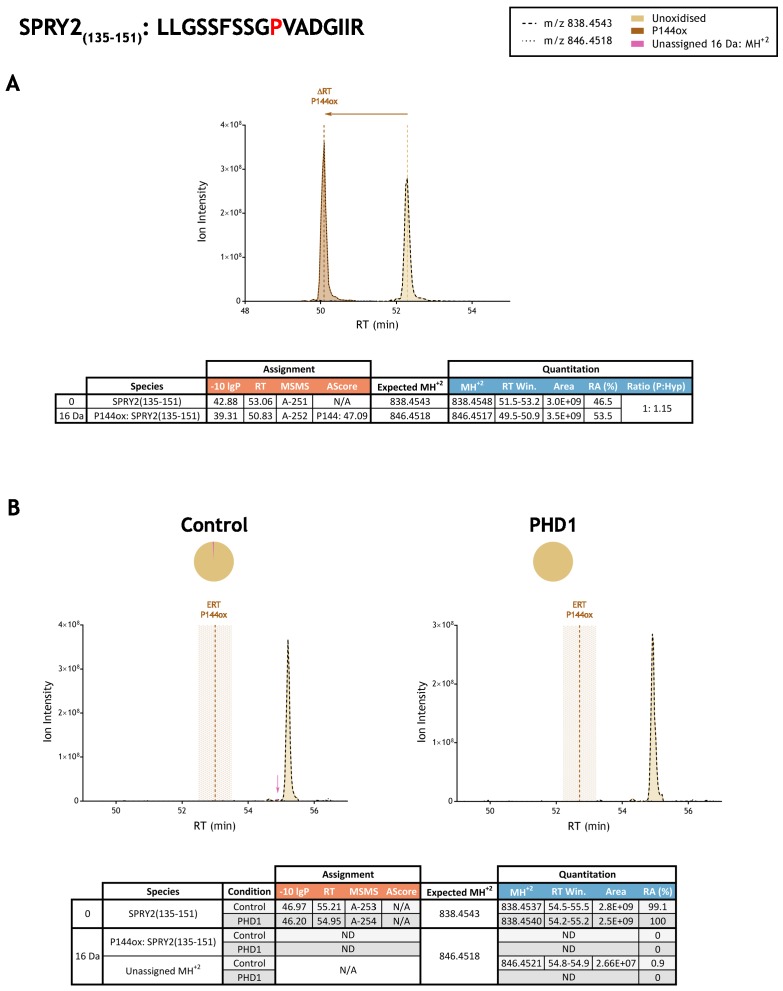
Quantitation of peptide oxidation on SPRY2(135–151) following reaction of full-length sprouty homolog 2 with recombinant PHD1.XIC data presented in (A) shows ion intensity and retention time (RT) characteristics of equimolar synthetic peptide standards for unoxidised and P144ox forms of the SPRY2(135–151) peptide. MSMS assigned species are coloured (see inset); vertical dashed lines define peak maxima used to derive ΔRT values for P144ox. Panel (B) shows comparable XIC data for protease-digested IVTT substrate under control (left) or PHD1-reacted (right) conditions. Peaks corresponding to unoxidised SPRY2(135–151) were assigned by MSMS (see inset for colour code); P144ox was not detected. The estimated RT (ERT) for P144ox, derived from (A), is indicated by dashed vertical line, shading corresponds to a 1 min RT window. Peptide ions of low abundance that were compatible with hydroxylation but not assigned by MSMS are indicated (pink arrow). Quantitative data for observed species are presented as pie charts with XIC data. Assignment and quantitation data are tabulated below each panel, table headers are as follows: (−10lgP) significance score of leading assignment at given (RT) with ambiguity score (AScore) for PTM localisation and reference to primary MSMS data in Supplementary file 1. Quantitative data reports ion counts (Area) of observed masses (MH+2) integrated over time (RT Win.), expressed as relative abundance (RA). Data on detection efficiency for synthetic peptides (Panel A, P: Hyp) is an aggregated ratio of prolyl (P) to hydroxyprolyl (Hyp) containing species.